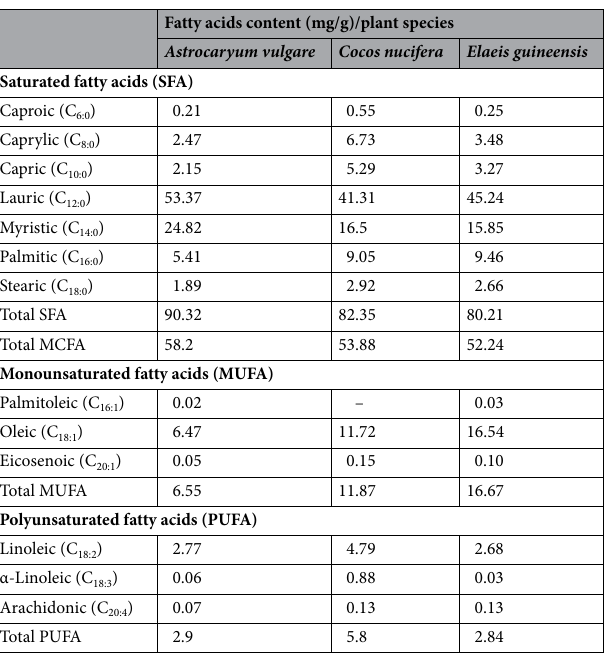
Table 1. Fatty acid profile of crude palm seed oils. Data are presented as average of two analyses, each performed in